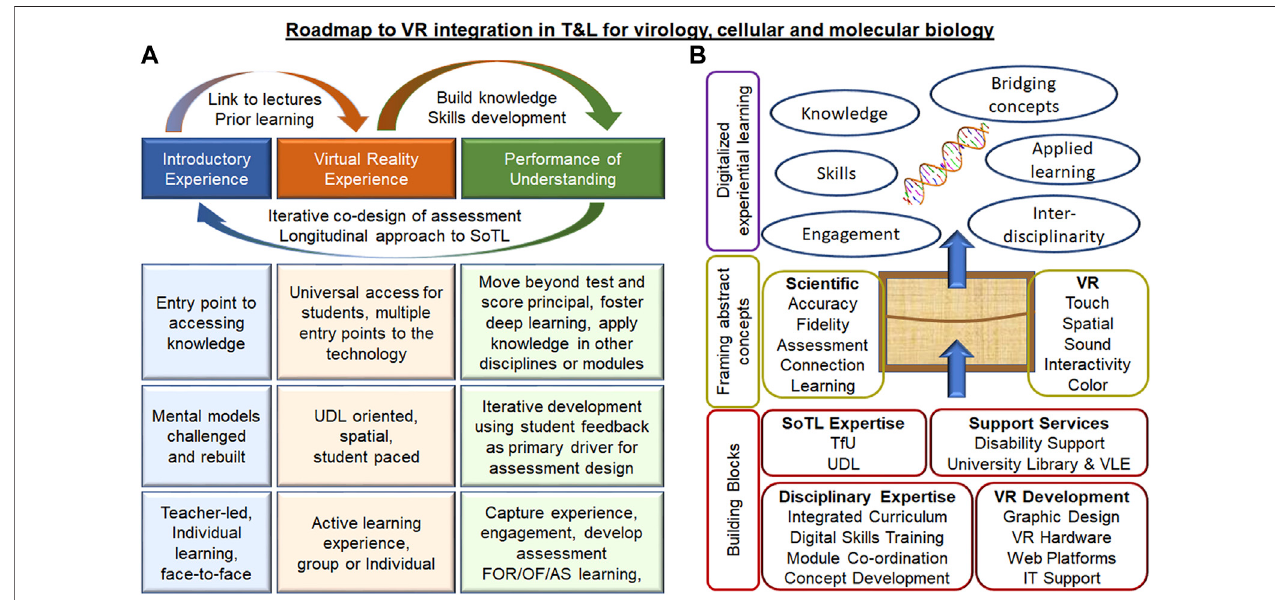
FIGURE 1 | Overview of the key considerations underpinning the effective integration and implementation of immersive learning technologies in teaching and learning of challenging molecular concepts. 1) Modular roadmap bridging the introductory experience with a performance of understanding, whereby a VR experience acts asathroughlineupon whichto scaffold the overalllearning experience. 2) The collaborative expertise required to successfully design and integrate aVRexperience within modular content highlights the true potential of this multi-disciplinary approach to T&L in higher education.